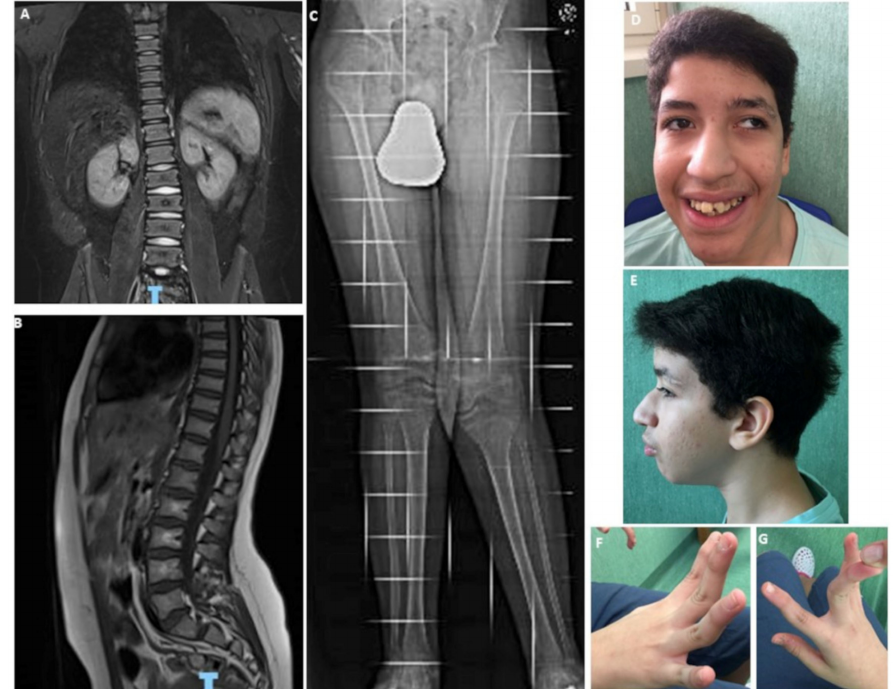
Figure 1. ( A , B ) MRI of lumbosacral spine at 13 years. Note the altered morphology of the vertebral bodies, which have a reduced height secondary to non-recent vertebral compression fractures, more marked in L5. The vertebral canal has a regular diameter. ( C ) X-ray of lower limbs showing right hip subluxation and a severely valgus left knee. ( D – G ) Physical examination of the patient at 13 years old, showing divergent strabismus, open mouth appearance, large and malpositioned teeth, hypermobility of distal interphalangeal